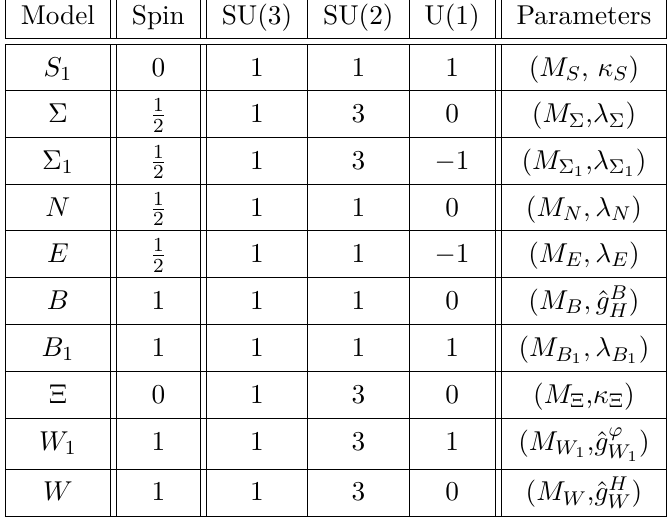
Table 2 . The single-field extensions listed in the first column can make tree-level contributions to m W . They have the quantum numbers listed in the following three columns, and the notations for their masses and couplings are given in the last column.